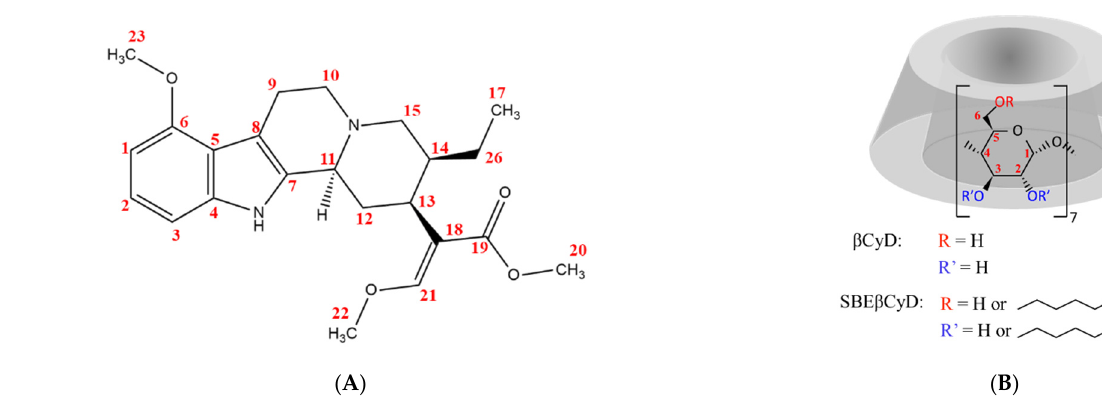
Figure 1. Chemical structure and numbering of mitragynine ( A ) and cyclodextrins used in this study ( B ) (the word “or” was inserted to denote the random substitution in SBE β CyD). Cyclodextrins (CyDs) are host molecules that are widely used in supramolecular chem- istry [13]. They have a truncated cone shape with a hydrophobic cavity and a hydrophilic outer surface that allows them to form inclusion complexes with various guest